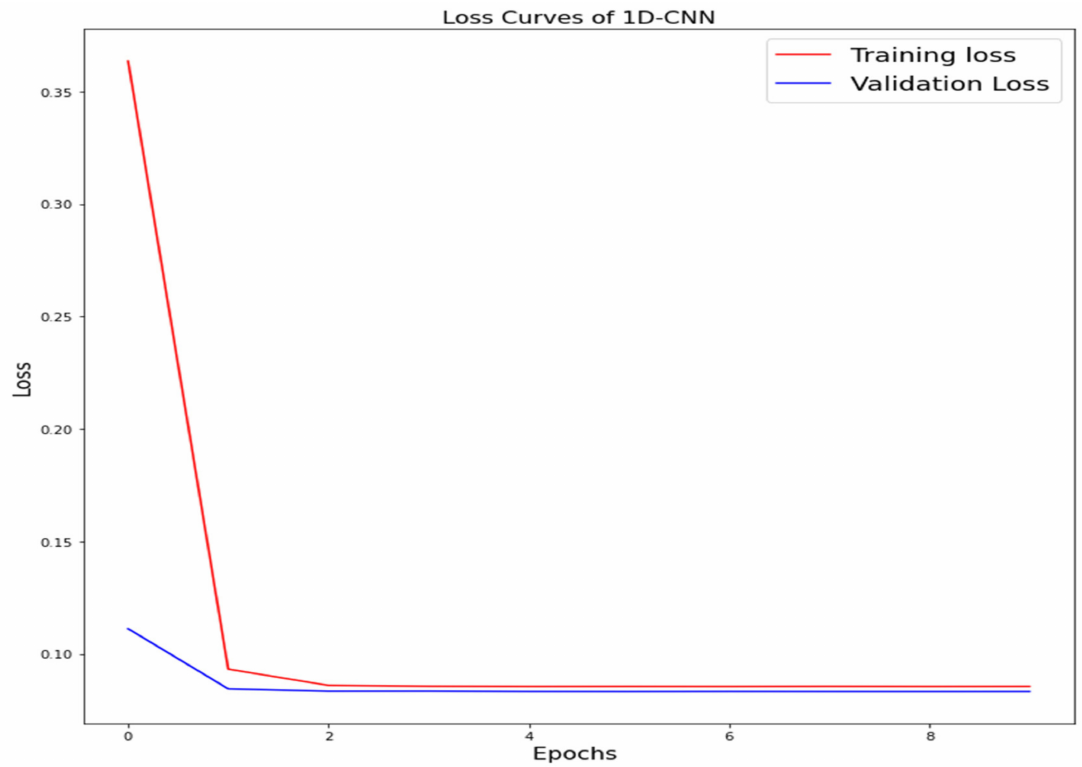
Figure 9. Loss curve of one-dimensional convolutional neural network